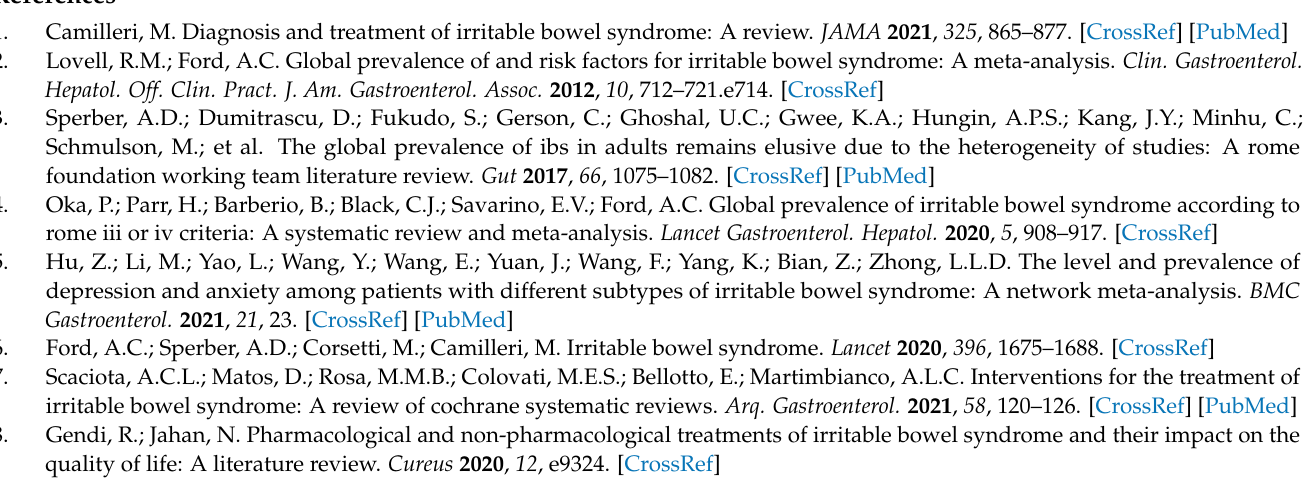
Forest plot for subgroup analysis of IBS subtype; Figure S3—Forest plot for subgroup analysis of study duration; Figure S4—Forest plot for subgroup analysis of symptom assessment method; Figure S5—Forest plot for subgroup analysis of control group type; Figure S6—Forest plot showing standardized mean differences for IBS-QoL subscale score; Table S1—Sensitivity analysis for the outcome of IBS symptoms severity; Table S2—Sensitivity analysis for the outcome of IBS-related quality of